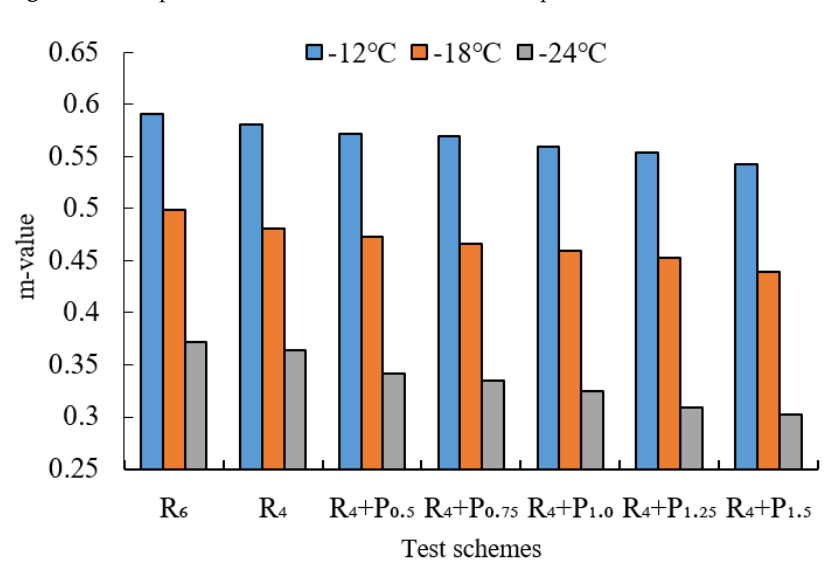
Figure 14. m-value of PPA – SBR and DH – 70# asphalt.